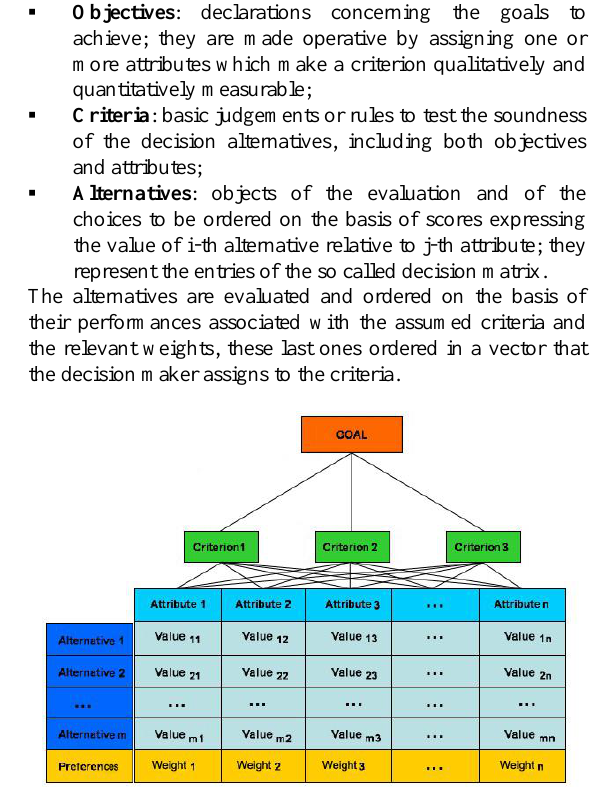
Figure 2. The hierarchy of dominance Fig. 2 represents a dominance hierarchy, a reticular